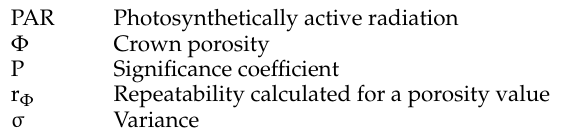
Figure S1: Pruning fresh weight relation with crown porosity; Table S1: Tree dimensions for tested years in different olive cultivars for each pruning treatment. Values are mean ˘ standard deviation. Different letters showed significant differences ( ρ < 0.05) according to Duncan’s test between different pruning treatments and in the same